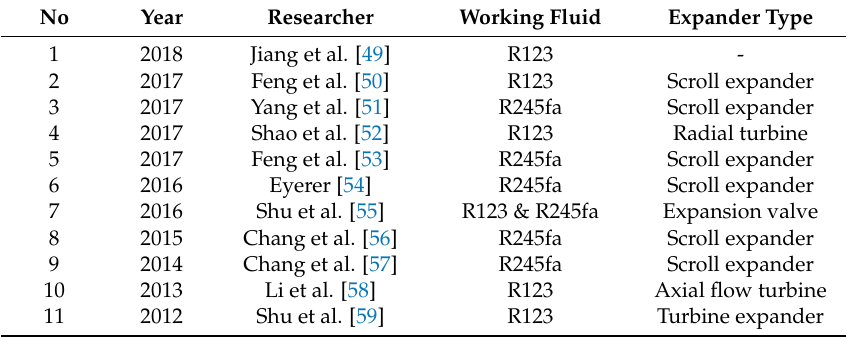
Table 2. Previous completed experiments using R245fa and R123 as working fluids.